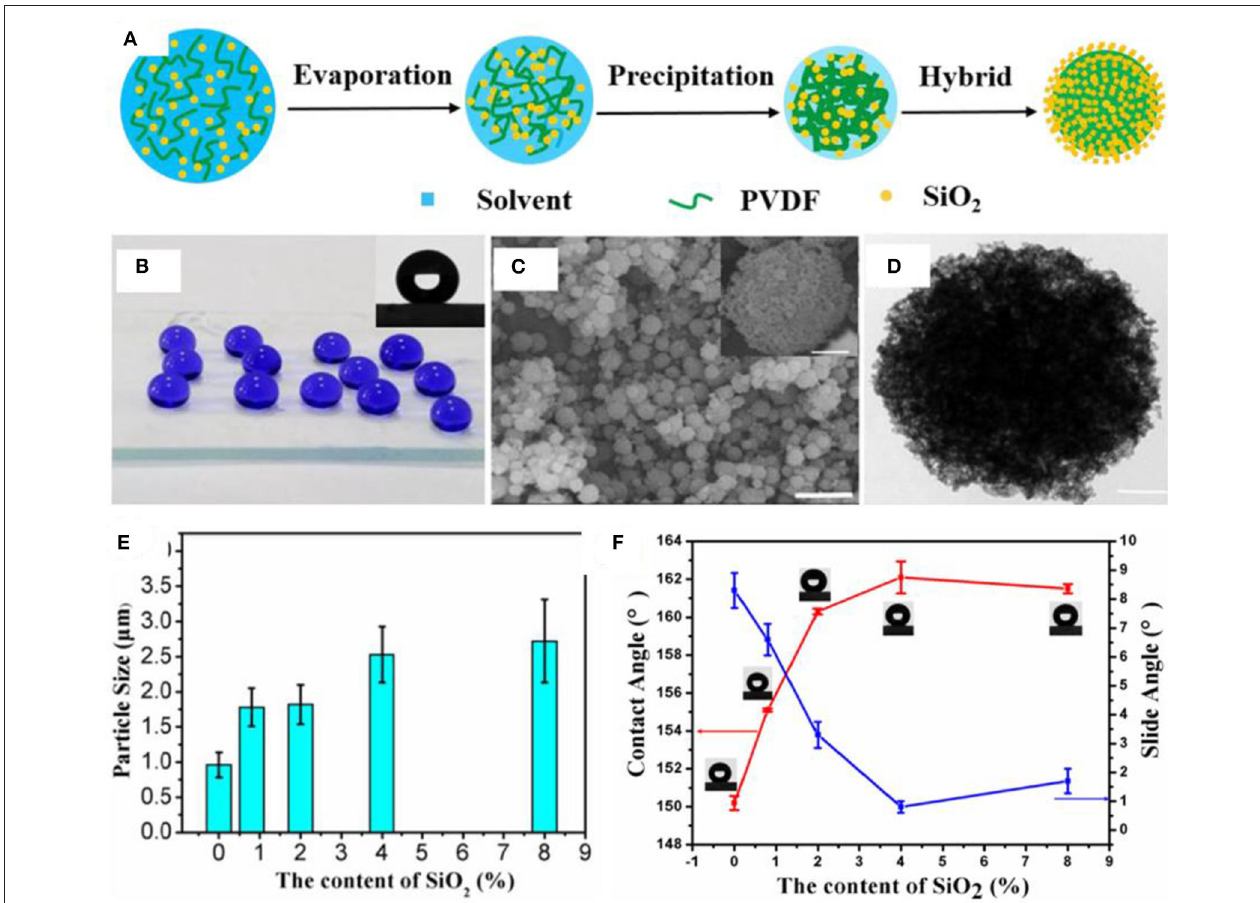
FIGURE 6 | (A) Schematic showing the procedure for synthesis of hierarchical hybrid microspheres. (B) Digital images showing the water droplets on the superhydrophobic surface, whereas optical photograph in the inset represents contact angle measurement (C) . SEM (C, scale bar = 10 and 1 µ m for inset) and (D) transmission electron microscopy (TEM) images showing the morphology of electrosprayed hybrid microspheres. (E) Plot showing the change in diameter of hybrid particles as a function of silica concentration. (F) The graph shows the effect of silica content on contact angles and sliding angles of water drops. Adapted from Gao et al. (2017a) . With permission from Elsevier, copyright